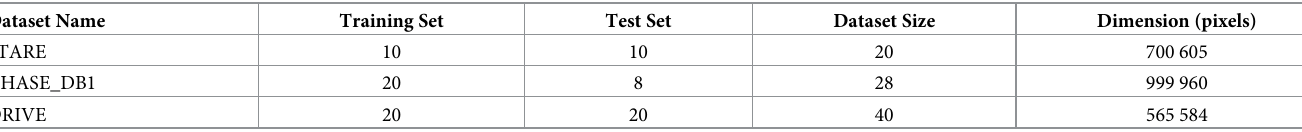
Table 4. Summary of datasets used in the experiments. Dataset